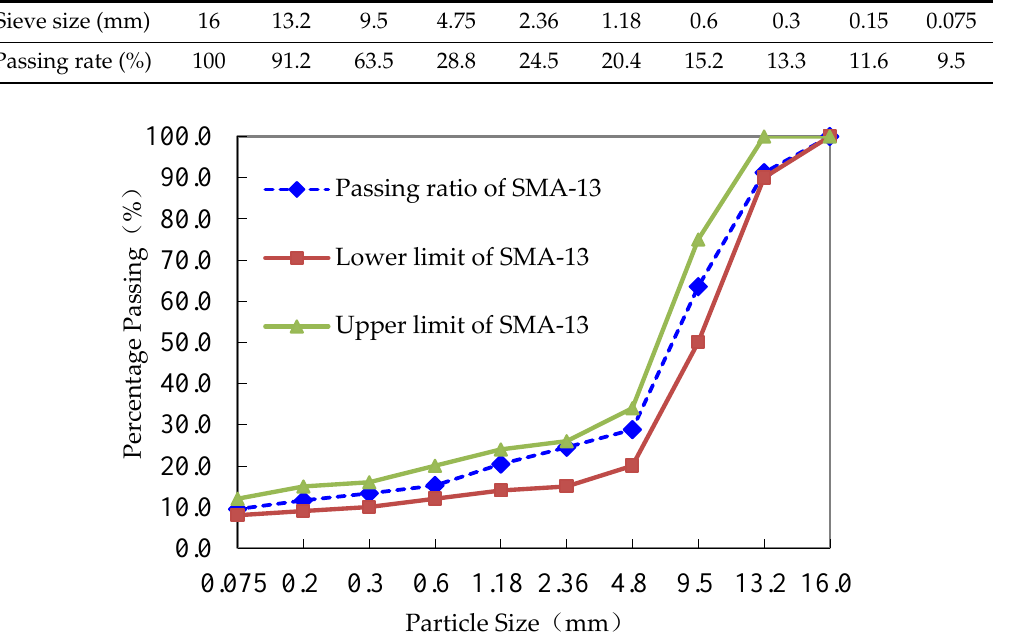
Figure 1. Gradation diagram of SMA-13.